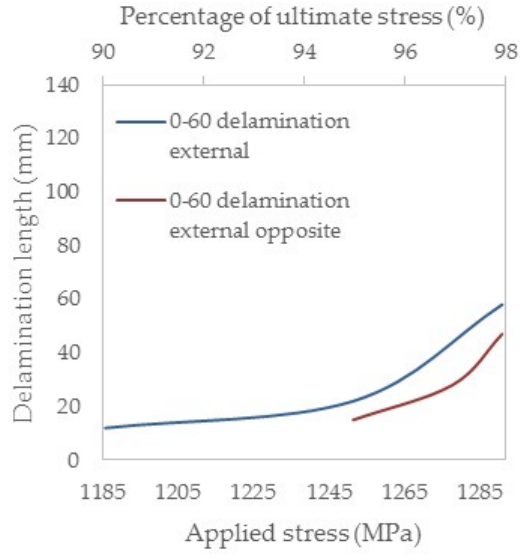
Figure 10. Evolution of delamination length in the [0°/60°] 2s laminates.